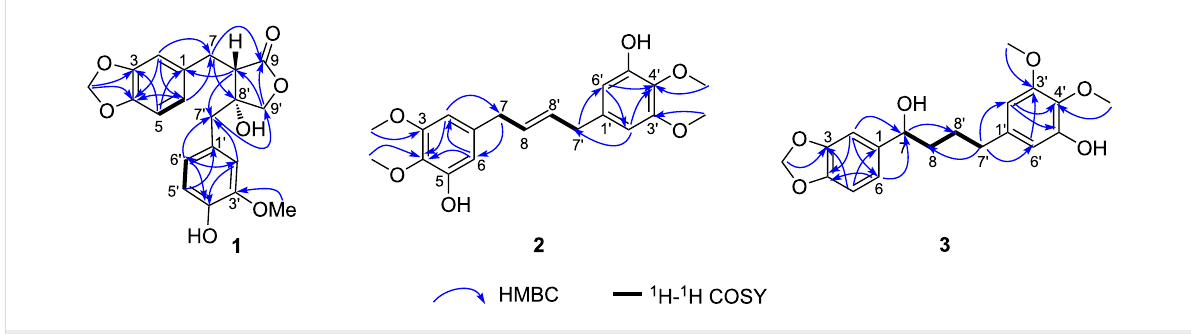
Figure 2: Key HMBC and 1 H- 1 H COSY correlations of 1 – 3 .